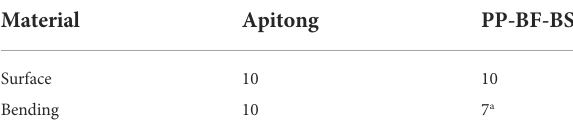
TABLE 2 Material ranking/scoring for PP-BF-BS compared to Apitong Slaven et al., 2022. Material Apitong PP-BF-BS Surface 10 10 Bending 10 7